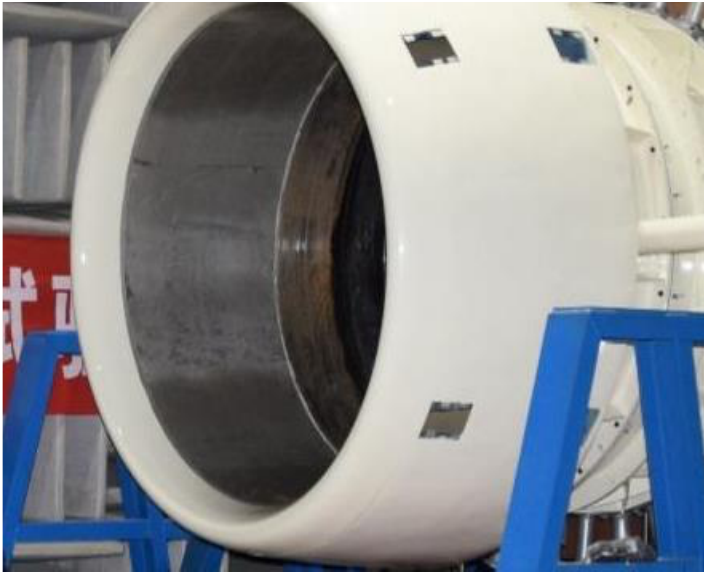
Figure 12. Test piece of “seamless acoustic liner” with zero splice. Table 4. Main structure parameters of acoustic liner with zero splice.